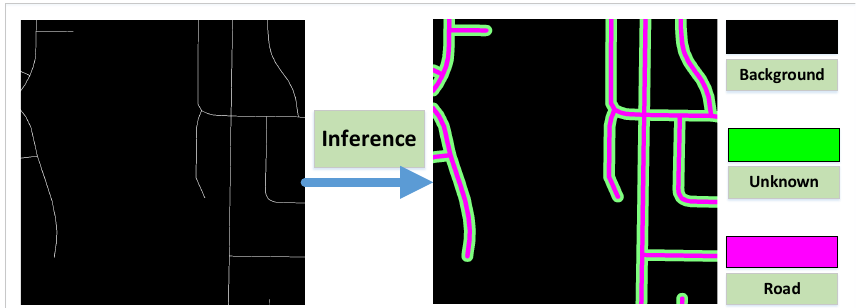
Figure 3. Weak road annotation